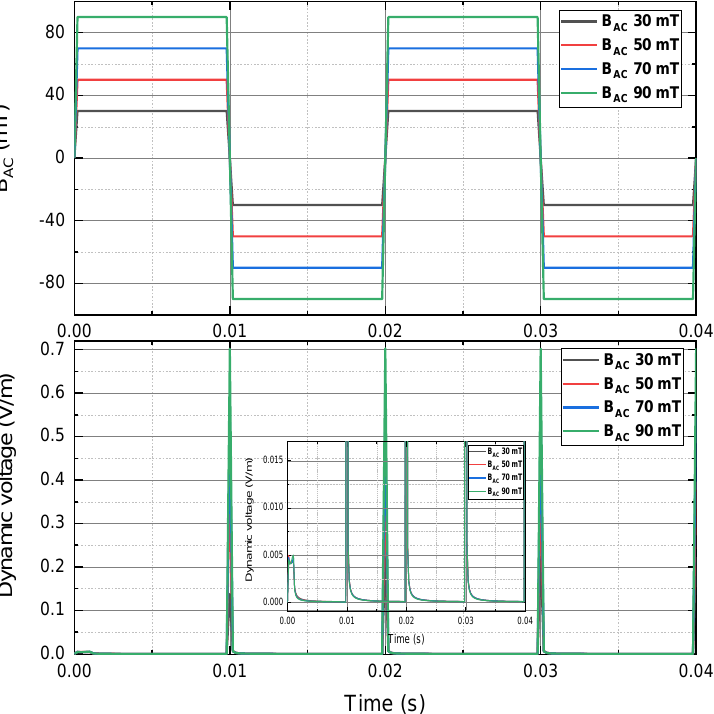
Figure 9. Instantaneous dynamic voltage of a 4 mm HTS tape, carrying a 30 A DC transport current and in the presence of the perpendicular square AC magnetic field at 50 Hz, with the peak magnitude 30 mT, 50 mT, 70 mT and 90 mT.